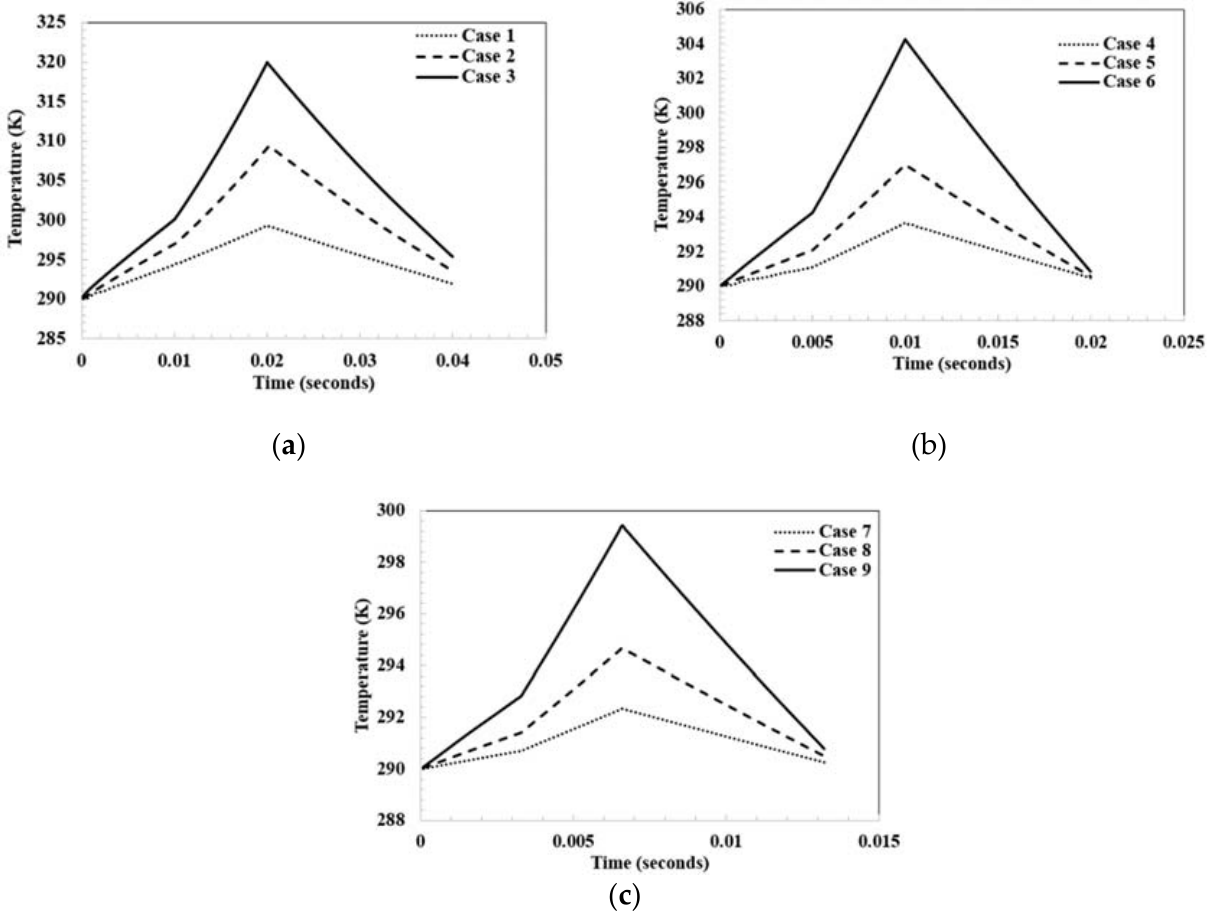
Figure 6. Average Internal Temperature for system rotational speed of ( a ) 1500 RPM, ( b ) 3000 RPM and ( c ) 4500 RPM.